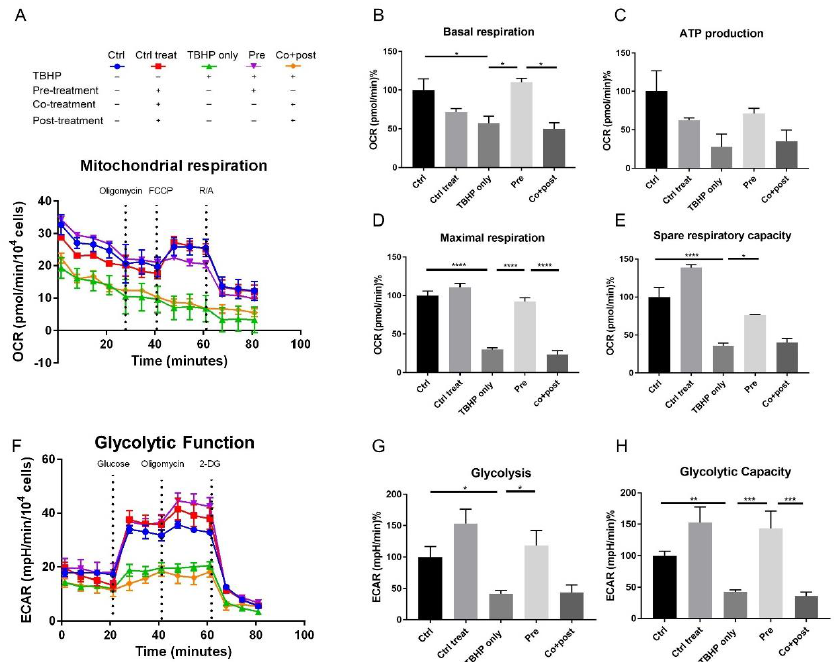
Figure 5. Effect of crocetin on bioenergetic function of ARPE19 cells. ARPE19 cells were pre-treated with crocetin in pre-treatment group (pre) and then all of the experimental groups except controls were exposed to TBHP for 4 h. After 12 h, oxygen consumption rate (OCR) and extracellular acidification rate (ECAR) were measured using a Seahorse XF e 96 analyzer to determine mitochondrial respiration ( A ) and glycolytic function ( F ) over time, respectively. Parameters of mitochondrial respiration including basal respiration ( B ), ATP production ( C ), maximal respiration ( D ), and spare respiratory capacity ( E ) were reduced in TBHP-only and co-treatment + post-treatment (co + post) groups compared to control (ctrl), but crocetin pre-treatment (pre) increased all the parameters compared to TBHP-only group. For glycolytic function, glycolysis ( G ) and glycolytic capacity ( H ) were determined and showed significant reduction in TBHP-only and co + post groups, while in the pre-treatment group (pre) significantly increased similar to controls. Data are shown as mean ± S.E.M. p -value: < 0.05 (*), < 0.01 (**), < 0.001 (***), < 0.0001 (****) n = 4, (One-way ANOVA, Tukey’s multiple comparison